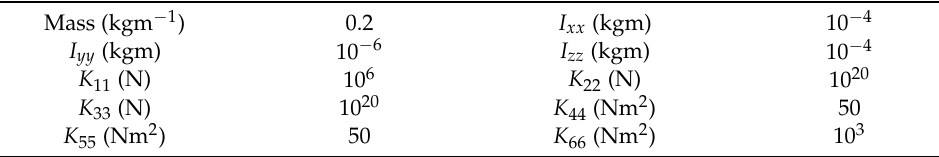
Figure 13. Clamped flexible blade. Table 1. Beam cross-sectional properties.